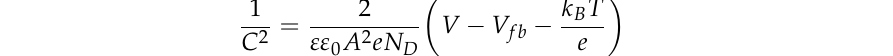
16 of 21 Figure 10. ( A ) Capacitance-voltage (C-V) and ( B ) conductance-voltage (G-V) data at a high fre- quency of 10 5 Hz evaluated on blank devices. The capacitance, C, and the conductance, G, were evaluated using the relationships 𝐺 =